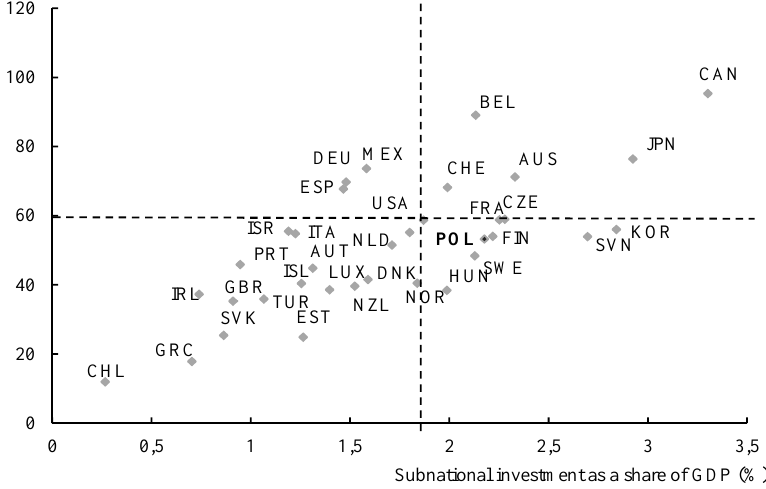
Note: Dashed lines represent unweighted averages for all OECD countries. Source: OECD (2016, p.